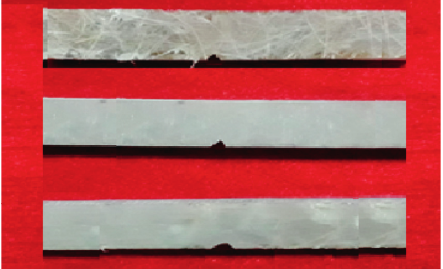
Figure 3: Impact test specimens.